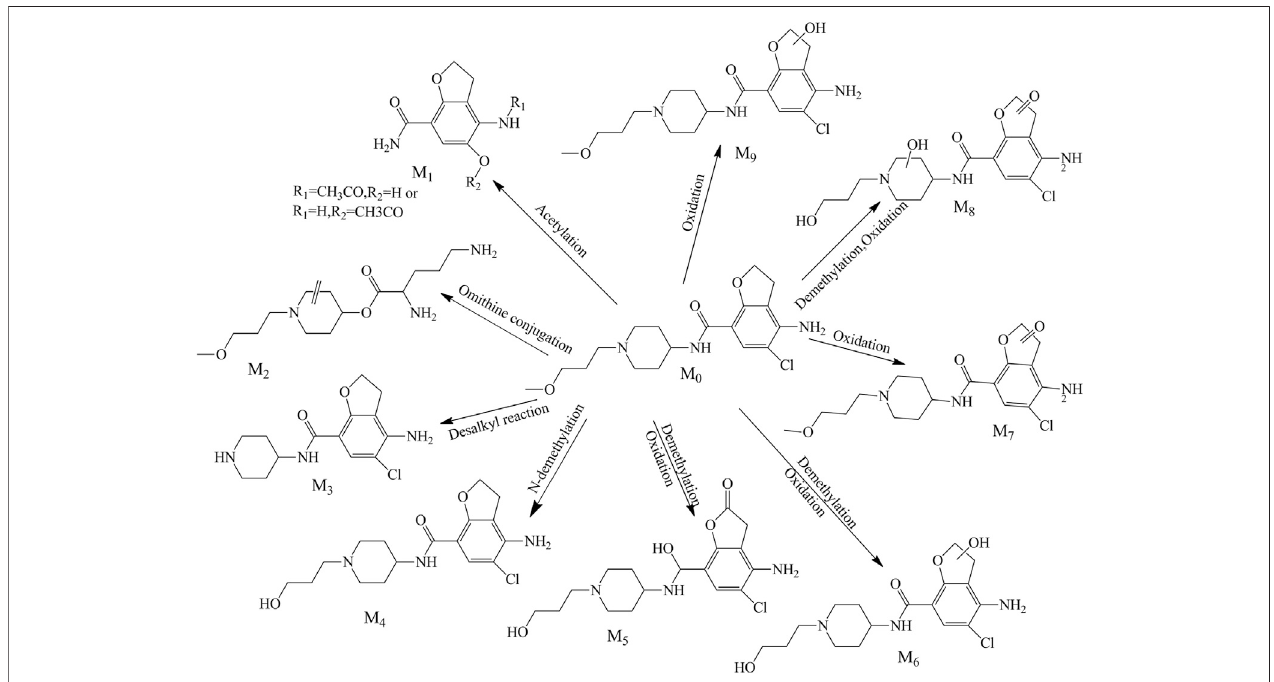
FIGURE 3 | Proposed metabolite pathway of prucalopride in the